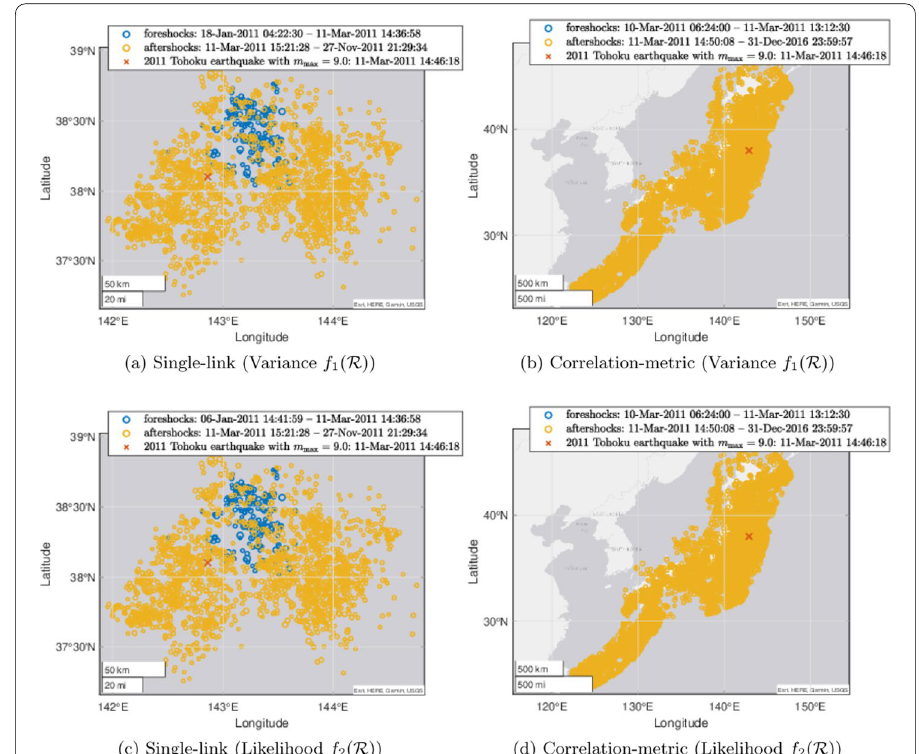
Fig. 6 Results of visual evaluation of the clusters which has the largest magnitude m max = 9.0 (when the number of clusters G = 8